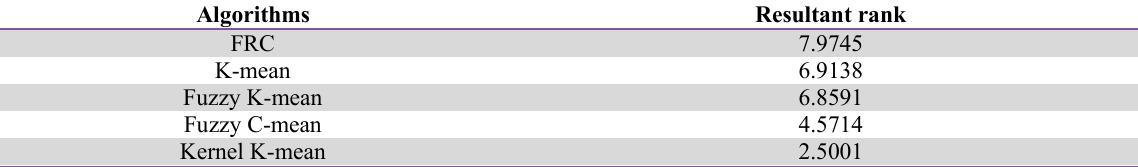
Resultant rank of clustering